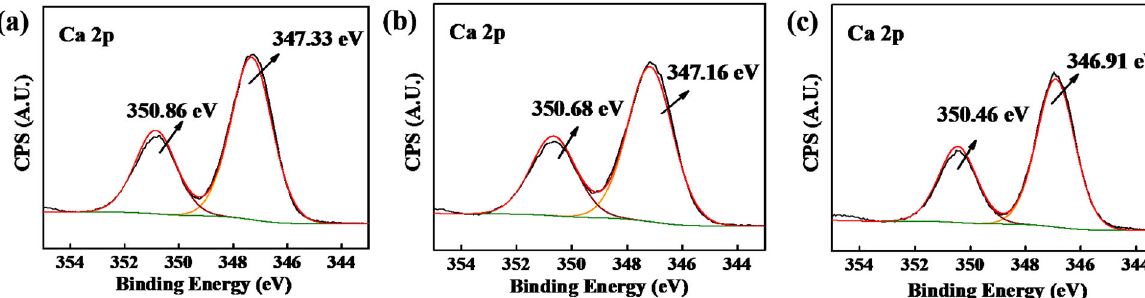
Fig. 9 Ca2p XPS spectra of CaCO 3 scales. a Without scale inhibitor, b with 30 mg/L PASP, c with 30 mg/L SiO 2 – NH 2